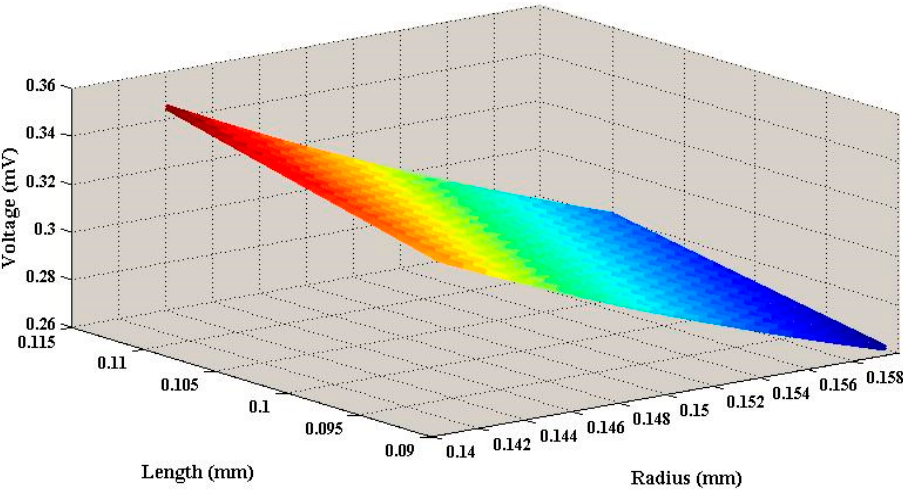
Figure 3. The relationship of the peak voltage with neck radius and length.